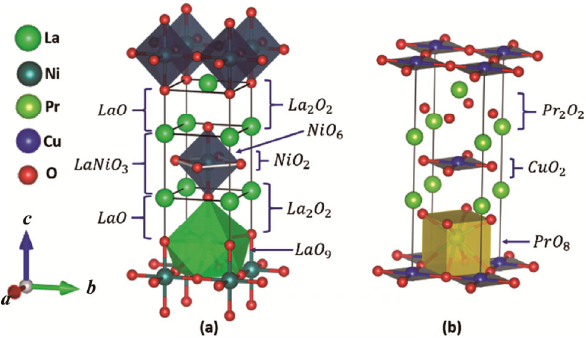
Fig. 2 (a) Half unit cell of T -type La (cid:2870) NiO (cid:2872) layered perovskite. (b) Unit cell of T ′-type Pr (cid:2870) CuO (cid:2872) ternary